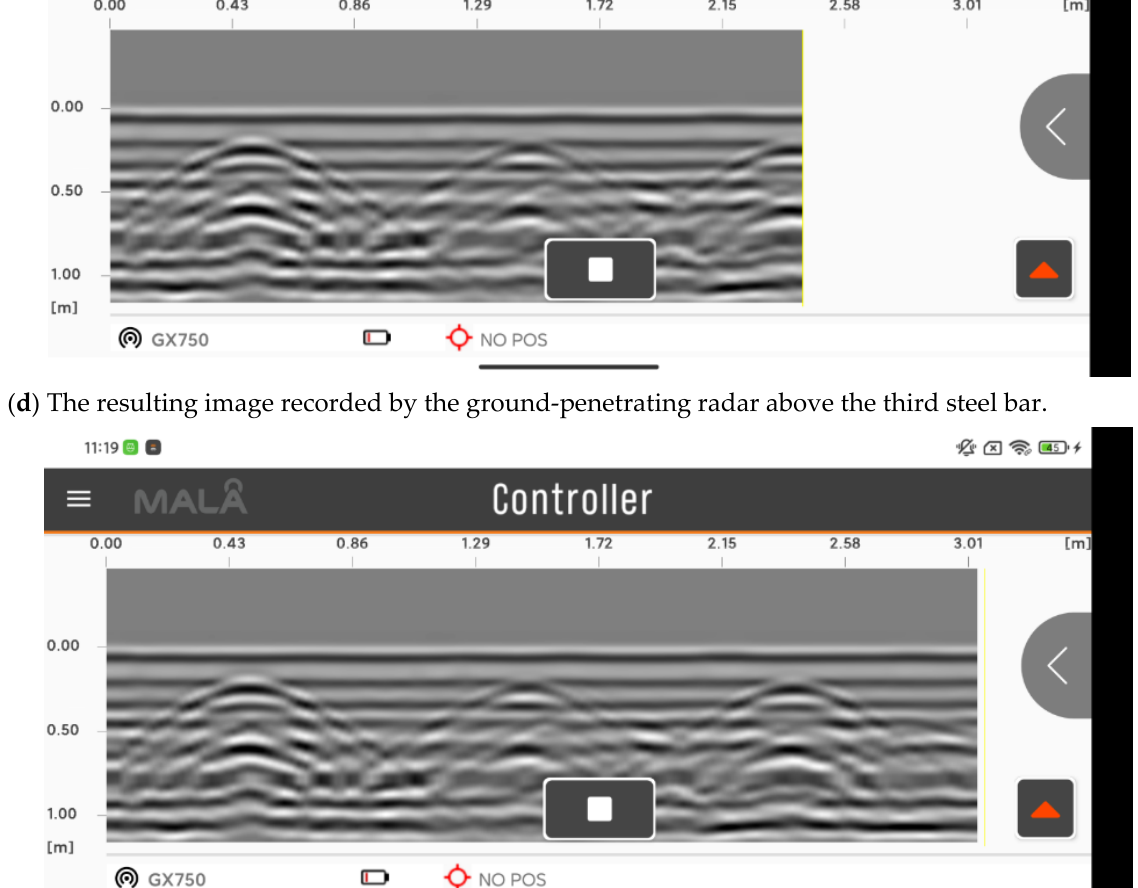
Figure 9. The ABD tool captures part of the process of the mobile phone screen. After we acquired the GPR images using MALA Controller software and inter- cepted the cell phone screen with ADB tool, according to the characteristics of the MA- LA Controller software interface, the image pixel coordinates were re-established after